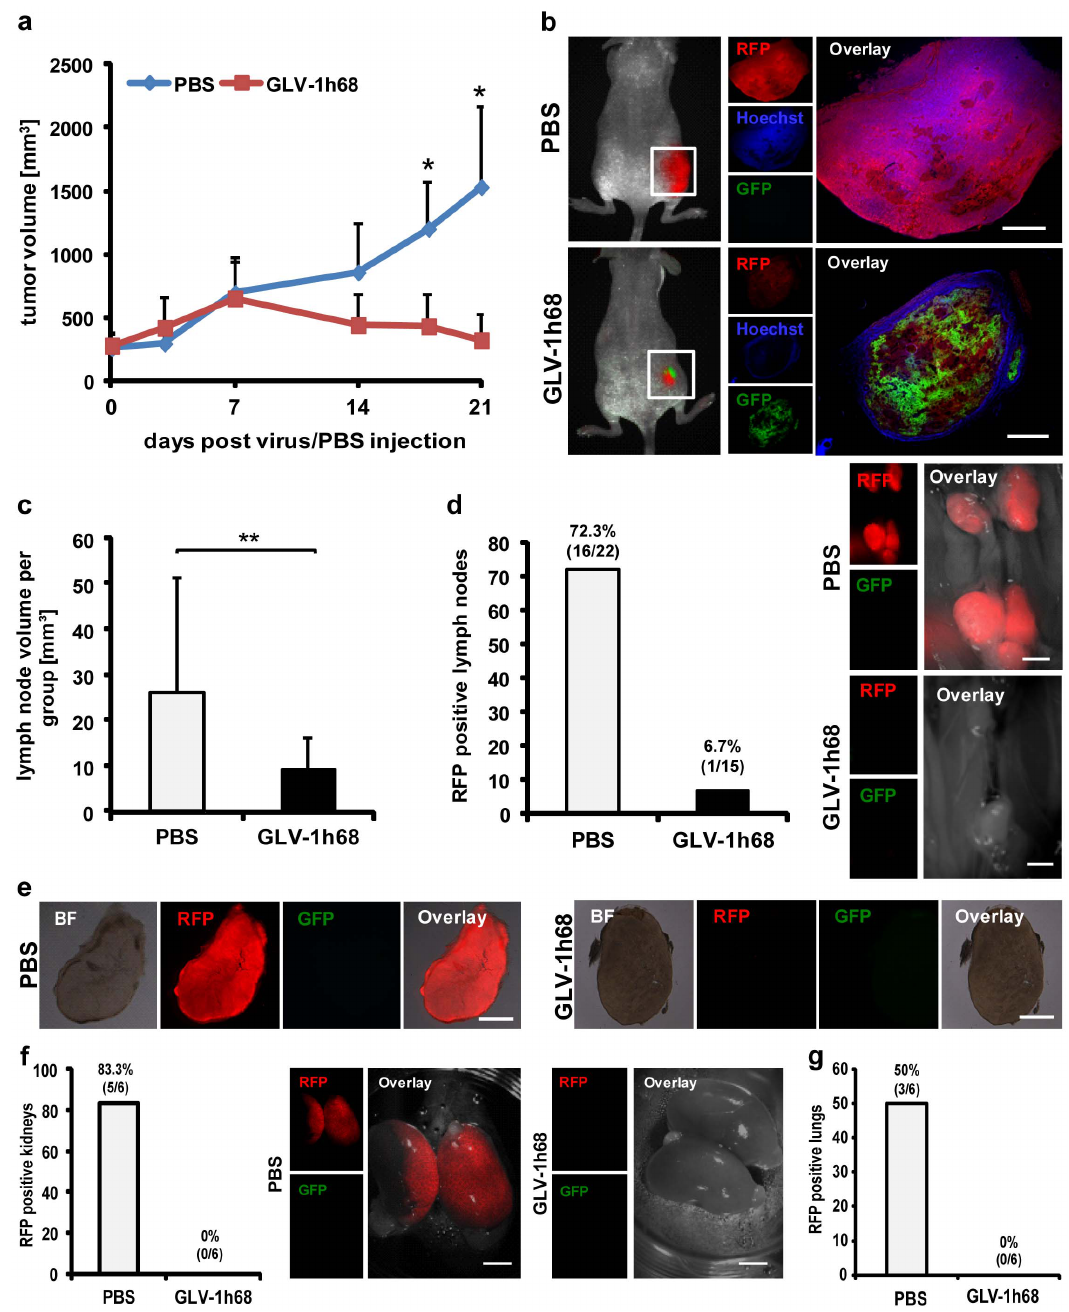
Figure 6. Influence of oncolytic virotherapy on C33A-RFP tumors and metastases. a Time curve of C33A-RFP tumor growth in 12 mice after administration of the oncolytic vaccinia virus GLV-1h68 and PBS, respectively (n=6). Analyses of C33A-RFP tumors and metastases in b-g were done 32 dpti and 21 days after administration of GLV-1h68 or PBS (dpi). Six mice were examined per group (n=6). b Left: C33A-RFP tumor-bearing mice 21 dpi. Right: 100 m m sections of a PBS and a GLV-1h68 treated tumor. Nuclei were stained with Hoechst dye, GFP is expressed by GLV-1h68 and RFP by C33A cells. c Volume of lumbar and renal lymph nodes and d percentage of RFP positive lymph nodes in PBS and GLV-1h68 treated C33A-RFP tumor-bearing mice (left). Right: Images of lumbar and renal lymph nodes in PBS and GLV-1h68 treated mice. e 100 m m sections of a PBS (left) and a GLV-1h68 (right) treated lumbar lymph node metastasis. f Left: Percentage of kidneys positive for RFP in PBS and GLV-1h68 treated mice. Right: Images of kidneys in the PBS and virus group. g Percentage of lungs positive for RFP in PBS and GLV-1h68 group. All images are representative examples. All scale bars represent 2 mm. doi:10.1371/journal.pone.0098533.g006 has no target structures to replicate in, explaining the absence of a Hence, there was an efficient diminishment of RFP expressing tumor cells in lumbar and renal lymph nodes by virus treatment. GFP signal. In addition, a drastic virus-mediated reduction of RFP Without C33A-RFP tumor cells in the lymph nodes GLV-1h68 in lungs and kidneys of C33A-RFP tumor-bearing mice was